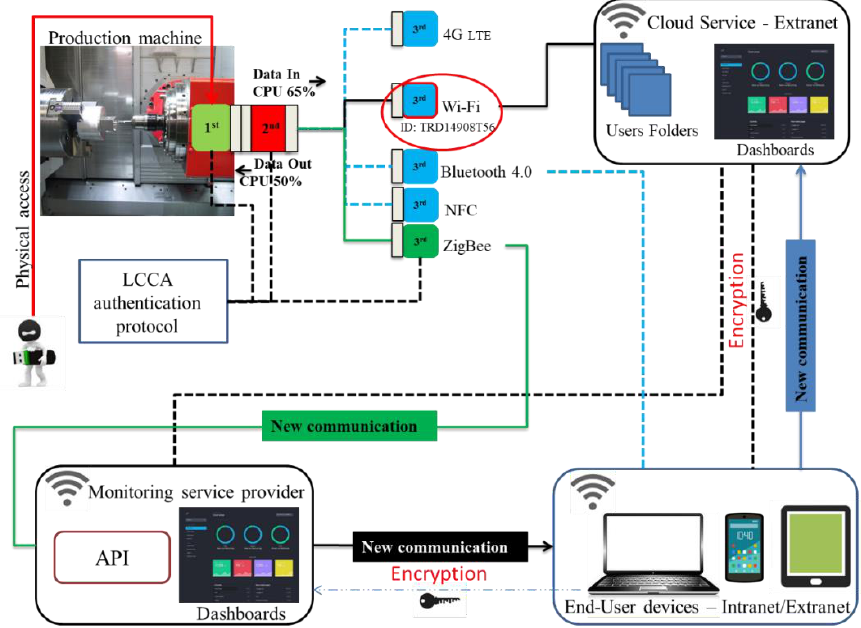
Figure 16. A DoS attack initiated via infected USB dongle.